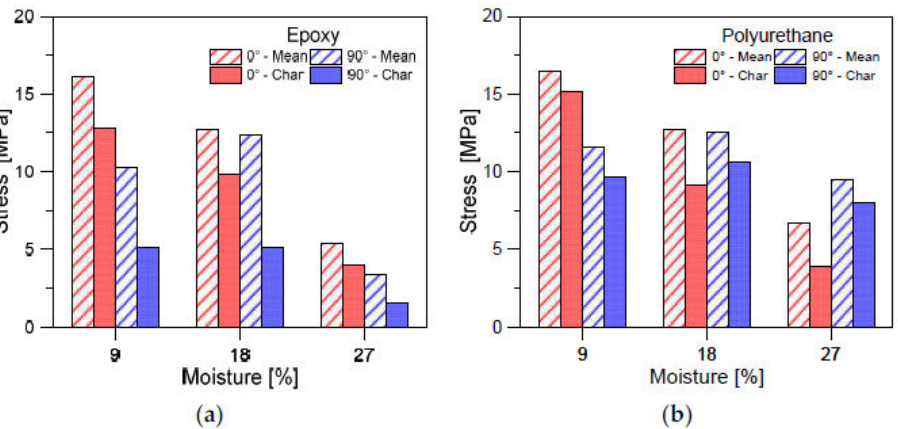
Figure 8. Stress peak at failure, as observed for ( a ) epoxy or ( b ) polyurethane bonded rods in various arrangements. Comparison of mean and characteristic experimental results.